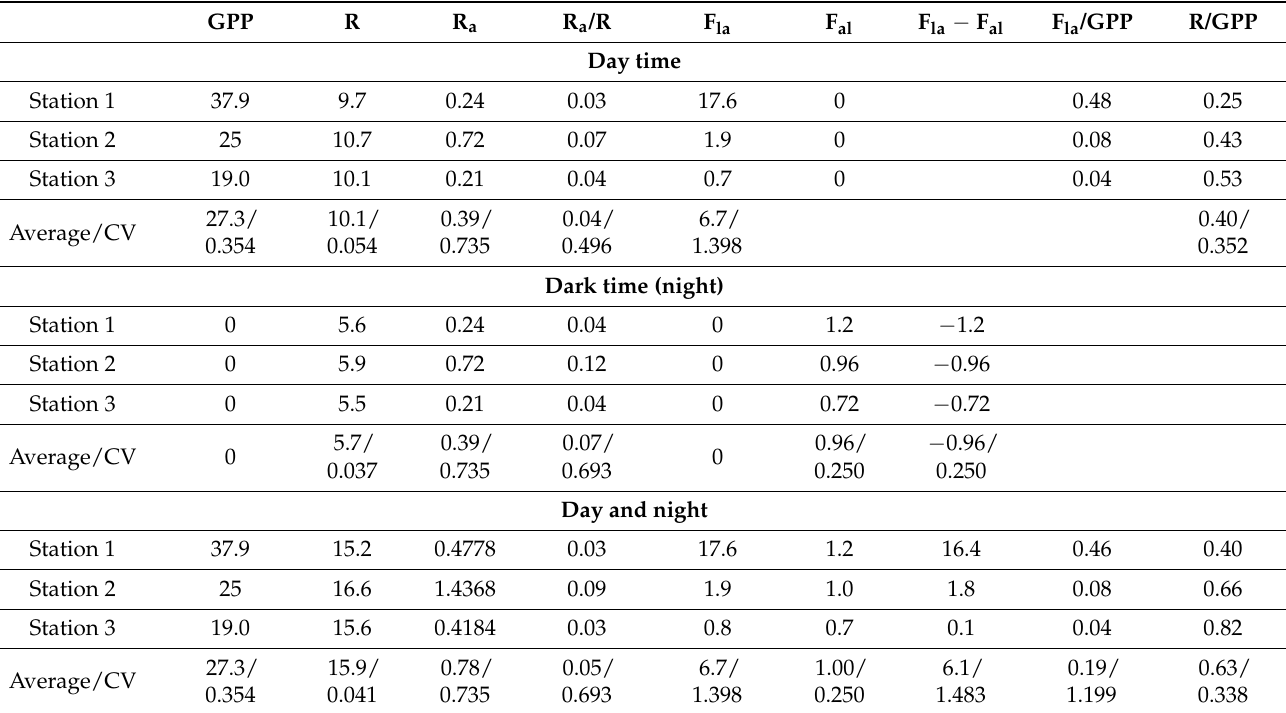
Table 2. Calculated indicators of the oxygen balance (mg O 2 m − 3 ) in Lake Moynaki, 15–16 September